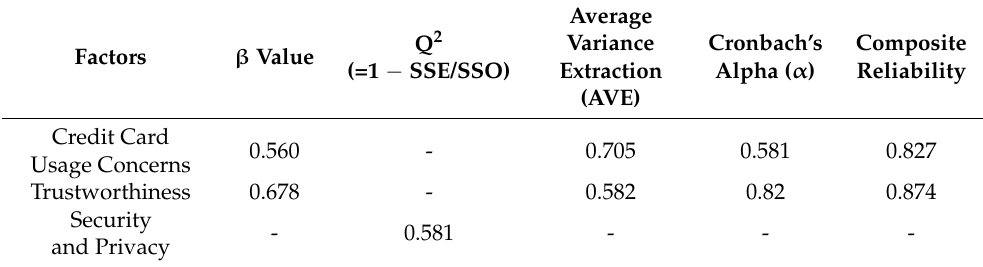
Table 6. Predictive relevance of model factors for NOON.